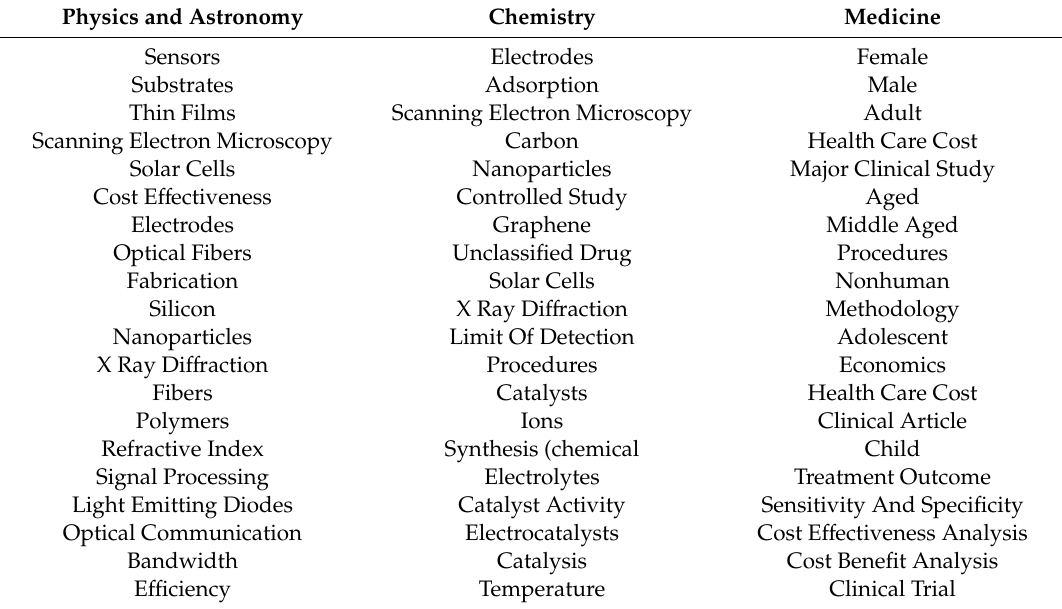
Table 9. Keywords on low cost research for the categories from 4 to